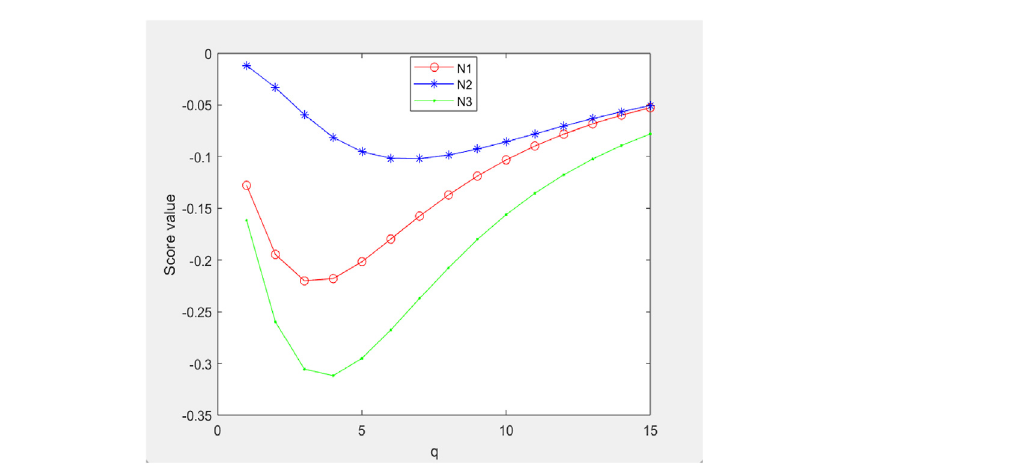
FIGURE 7 Score values of the alternatives for 1 ≤ q ≤ 15 under